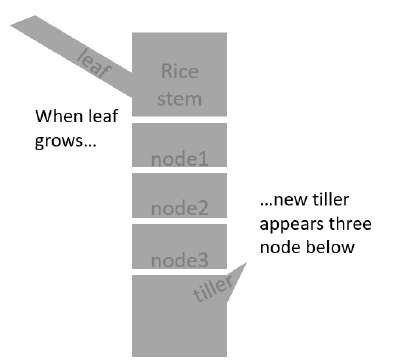
Figure 1. Synchronous growth theory in the development of rice tillers.